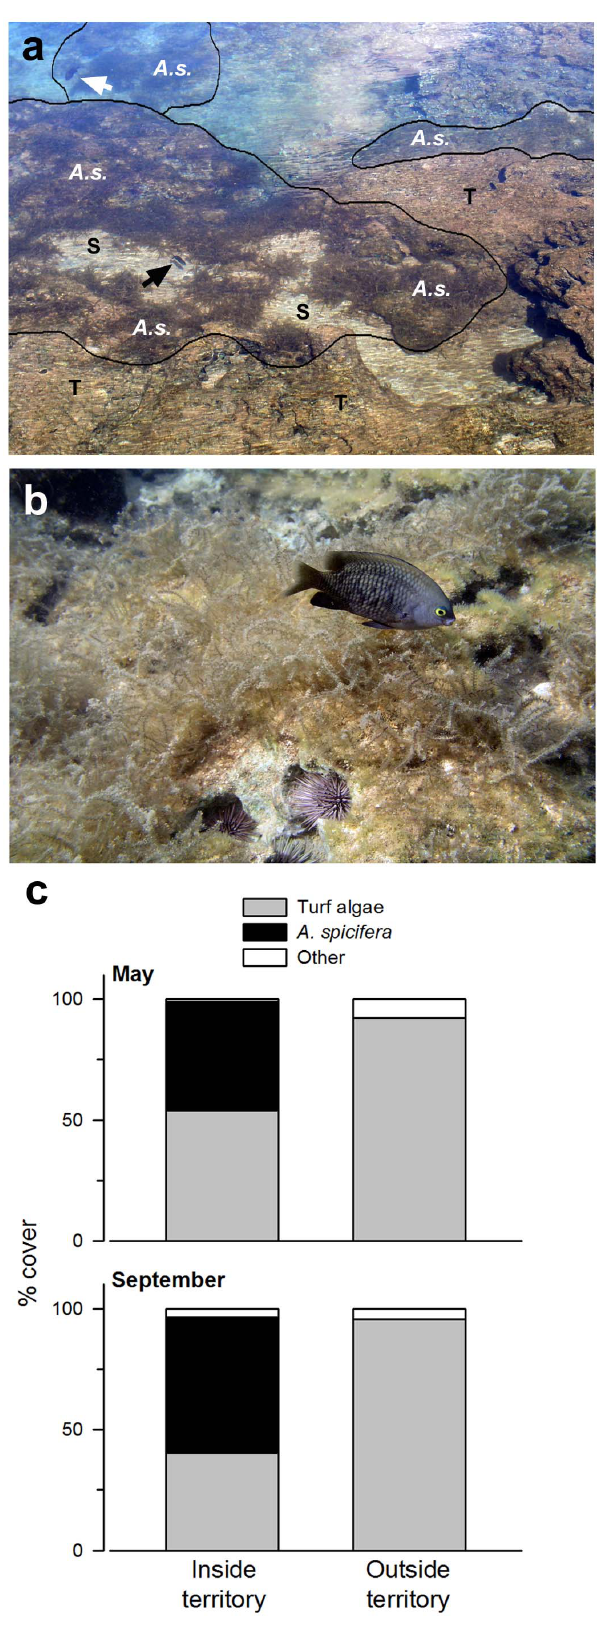
Figure 1. Invasive macroalga Acanthophora spicifera occurs exclusively within the territories of the algal farming damsel- fish Stegastesmarginatus . A) Oblique view of Stegastes marginatus (arrow) feeding patches with dense growths of the invasive red macroalga Acanthophora spicifera (A.s.), turf algae (T) and sand (S). B) S. marginatus defending a lush canopy of A. spicifera . C) Percent cover of benthos inside and outside S. marginatus territories in May and September